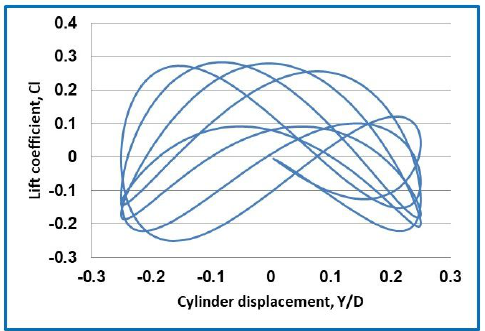
Figure 15: Drag coeflcient history at f v = 2 f s , inline flow vibration